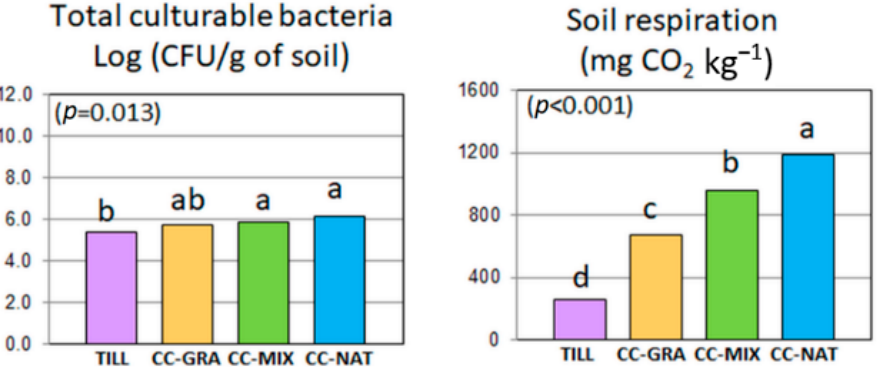
Figure 5. Total culturable bacteria and soil respiration of an olive orchard soil under different cover crop managements (TILL: tillage, CC-GRA: sown cover crop with gramineous and CC-MIX: sown cover crop with a mixture of species) and CC-NAT (cover crop with spontaneous vegetation). Mean comparison was performed using the rank-based Kruskal–Wallis test and Dunn’s all-pairwise multiple comparison test was applied when appropriate ( p < 0.05). (Different letters indicate significant differences p <